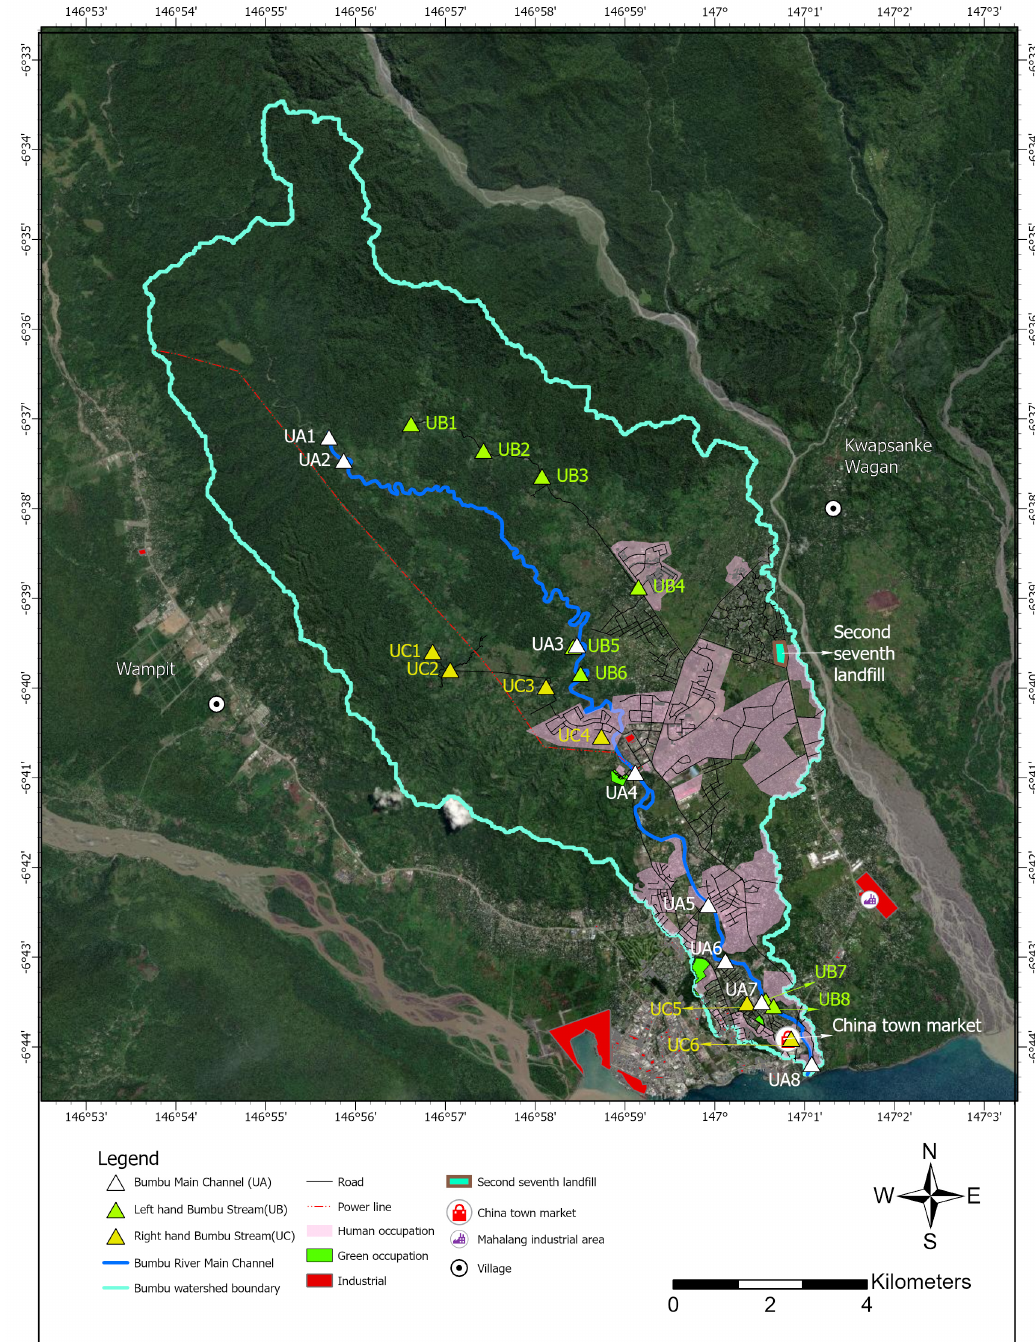
Figure 2. Position of 22 water sampling sites, Bumbu river main channel and other relevant sites of interest in the Bumbu Watershed.